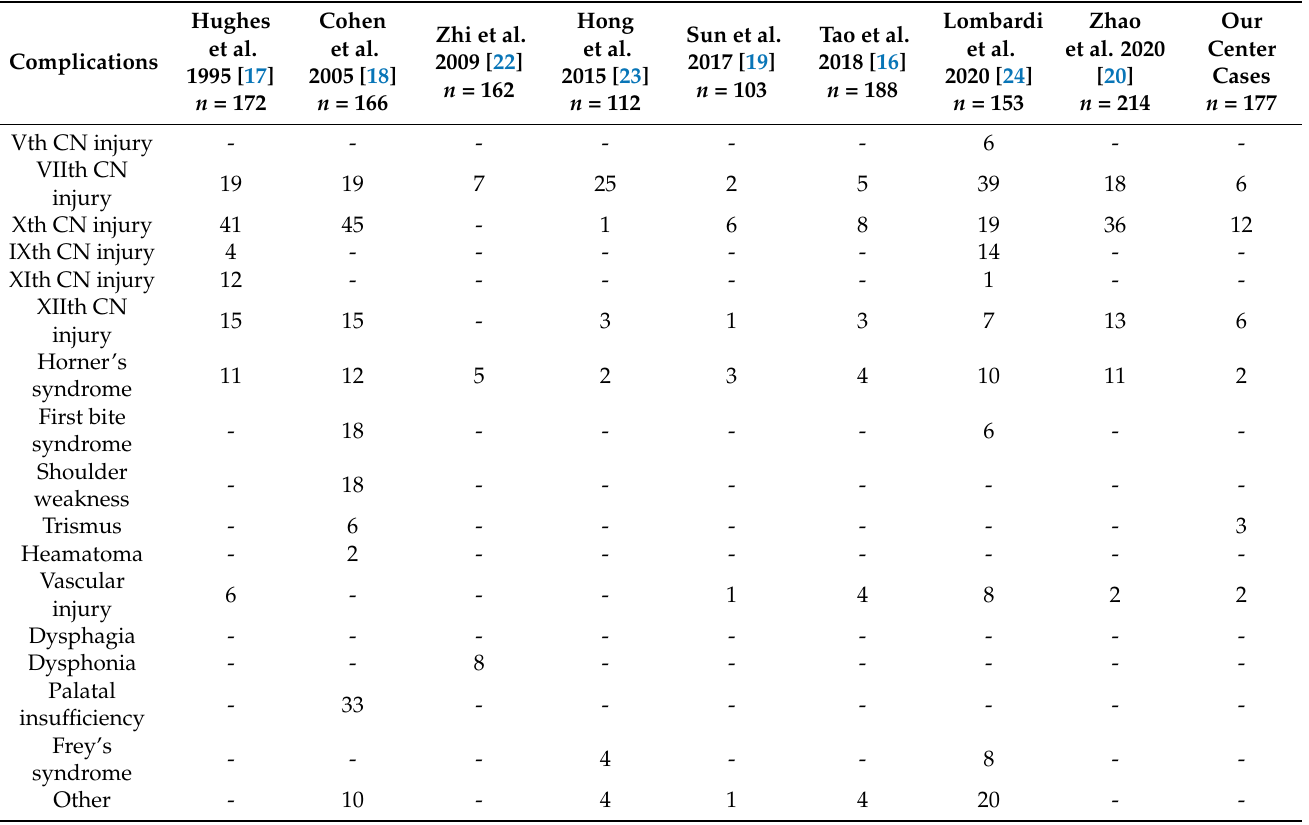
Table 4. Postoperative